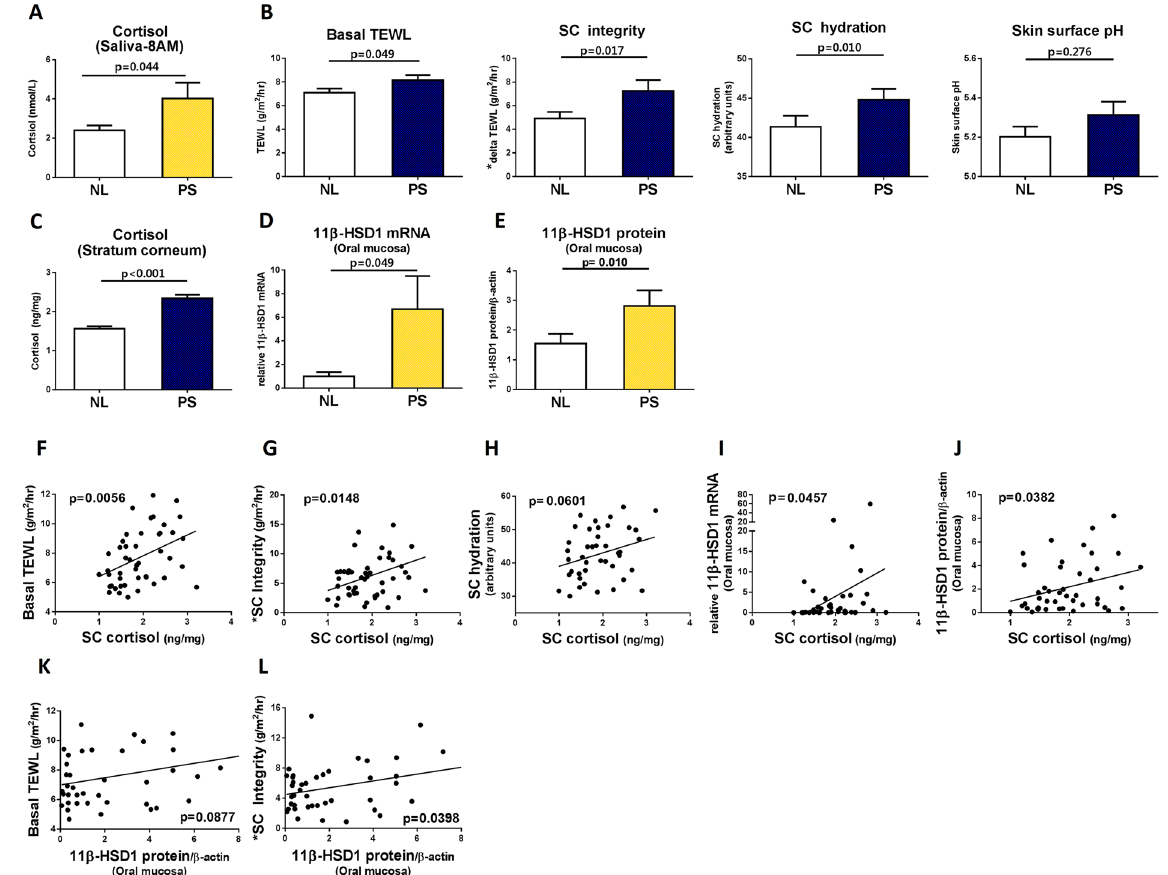
Figure 1. Accumulated cortisol of the stratum corneum and increased expression of 11 β -HSD1 in oral epithelium may contribute to the deterioration of the skin barrier function under psychological stress (n = 25). ( A ) Basal salivary cortisol around 8AM increased under psychological stressed status (PS) compared to normal status (NL). ( B ) Skin barrier function deteriorated under PS. Basal TEWL and SC hydration increased. SC integrity indicated by delta TEWL was compromised under PS. Skin surface pH showed no significant difference between PS and NL. ( C ) Cortisol of the stratum corneum was increased under PS. (D) mRNA and ( E ) protein expression of 11 β -HSD1 in oral mucosal epithelium increased under PS. Changes in skin barrier function (( F ) Basal TEWL and ( G ) SC integrity ) , and expression of 11 β -HSD1 (( I ) mRNA and ( J ) protein ) were correlated with the levels of SC cortisol. Changes in (H) SC hydration also showed a positive correlation with them but not statistically significant. ( K ) Basal TEWL and ( L ) SC integrity were correlated with the levels of 11 β -HSD1 but only SC integrity was statistically significant. * SC integrity = delta TEWL = PS TEWL (Post stripping with D-squame 15 times) - Basal